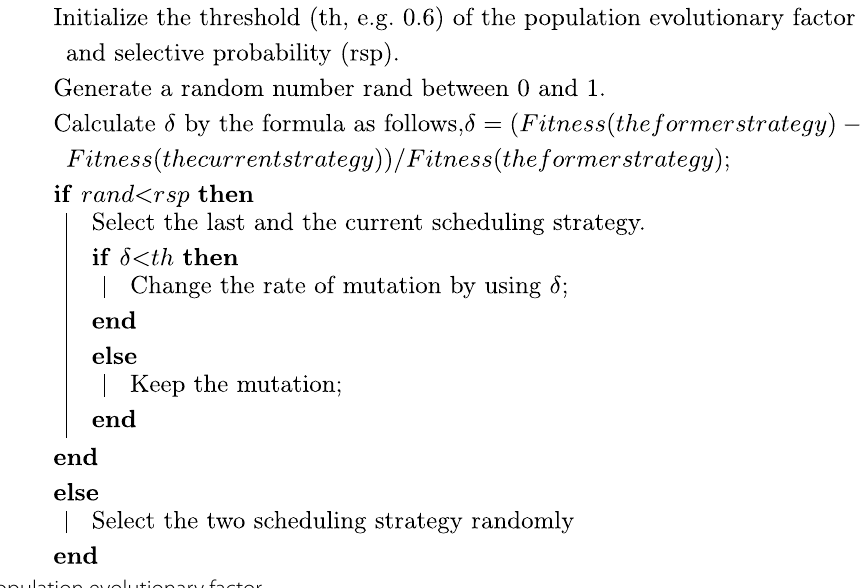
Algorithm 2 Population evolutionary factor Hunting